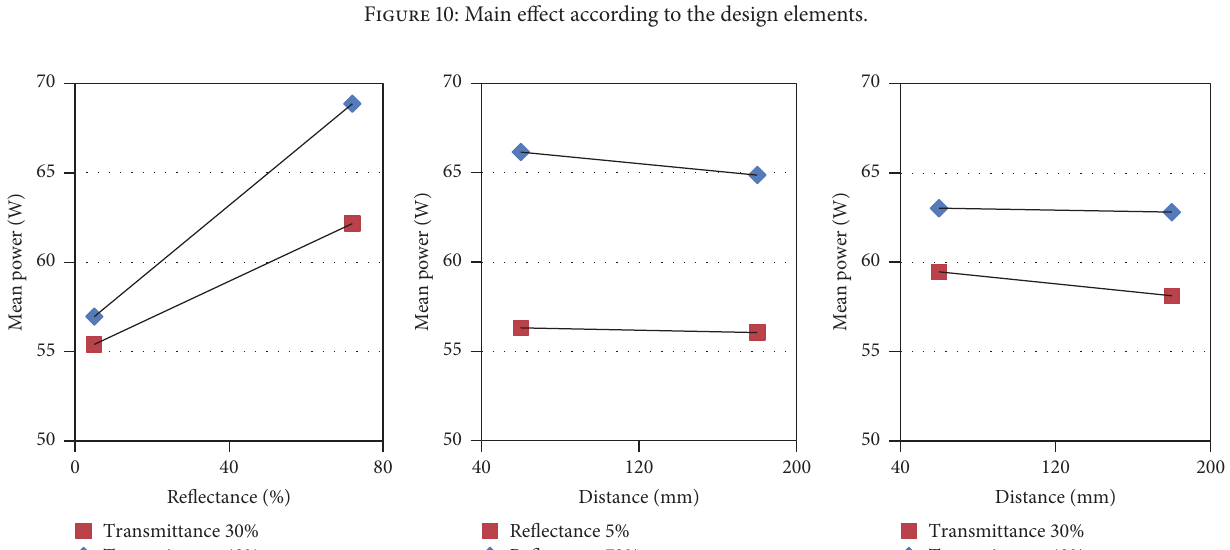
Figure 10: Main effect according to the design elements.